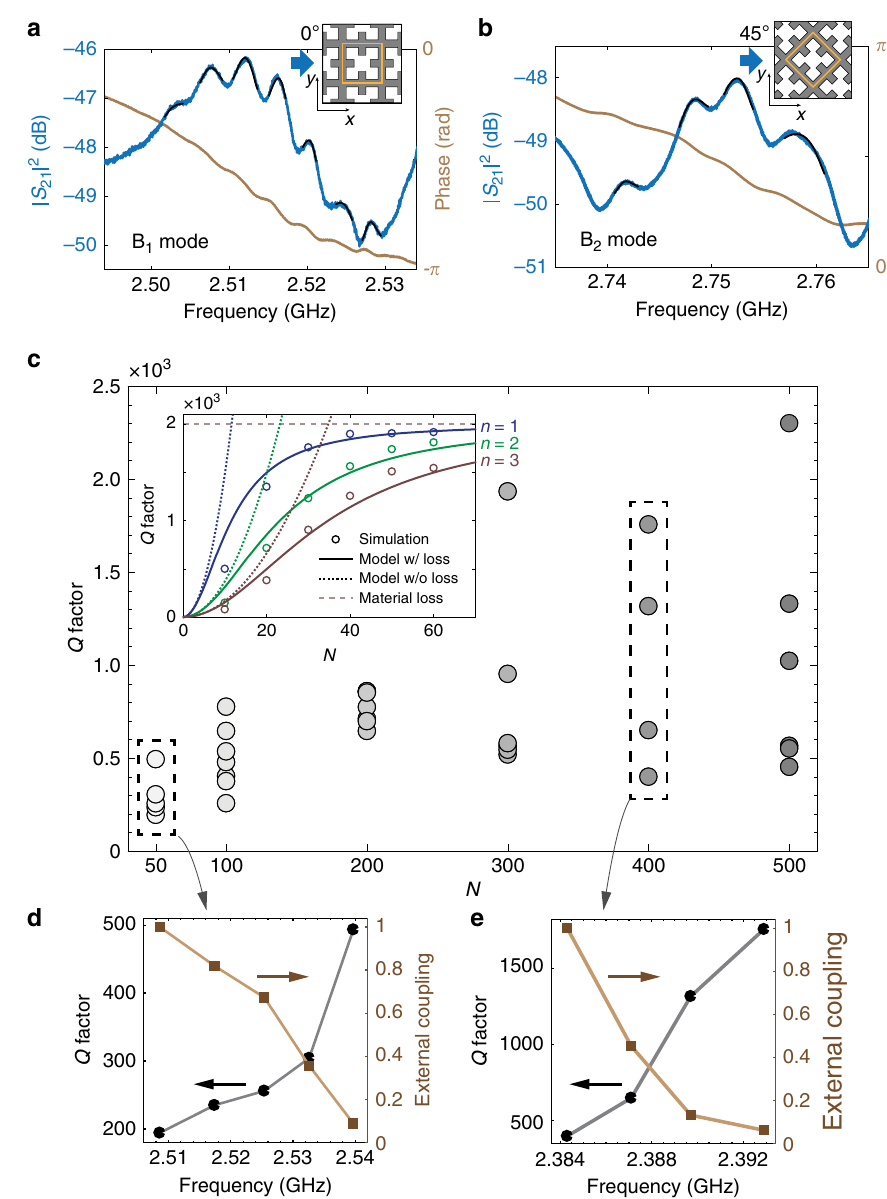
Fig. 3 Room-temperature mechanical spectroscopy. a , b Measured transmission spectrum of a 0° ( a )-oriented and 45° ( b )-oriented PnC exhibiting B 1 and B 2 standing-wave modes, respectively. The black curves are the fi tted transmission at resonances. For a broadband spectrum see Supplementary Note 3. c Observed room-temperature Q factors of B 1 standing-wave resonances versus the size of PnCs with N × N unit cells. The inset shows the Q factor of the fi rst three B 1 standing-wave modes in y -periodic PnCs by numerical simulation (circles) and theoretical modeling. Material damping of 0.1% is introduced in the simulation. d , e Q factor and normalized external coupling ( ω m / Q e , relative to the highest one) of the resonances in PnCs for N = 50 and